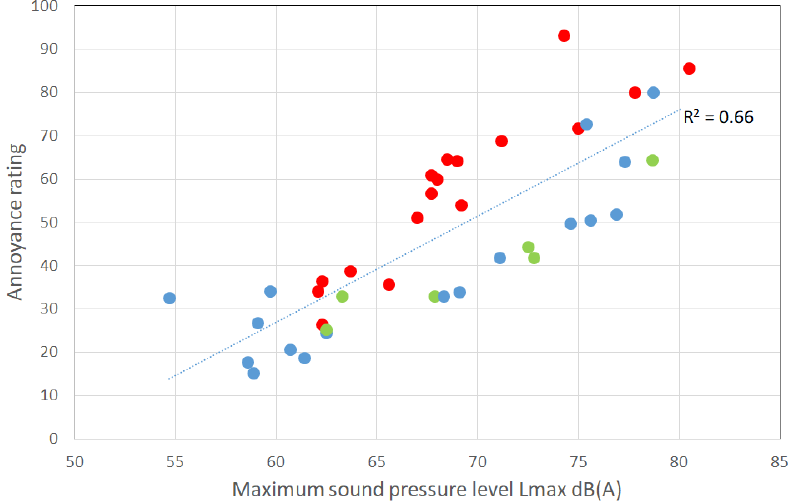
Figure 5. The relationship between perceived annoyance ratings and the maximum sound pressure level in dB(A). (Red dots: ICE cars, green dots: hybrid cars, and blue dots: electric cars).